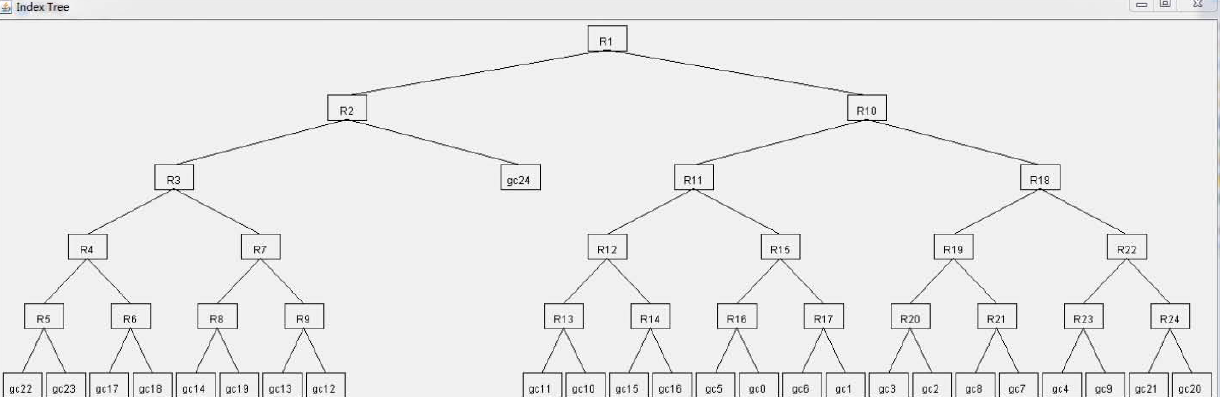
), and non-leaf nodes (e.g., R ) 24 5 and gc ). 22 23